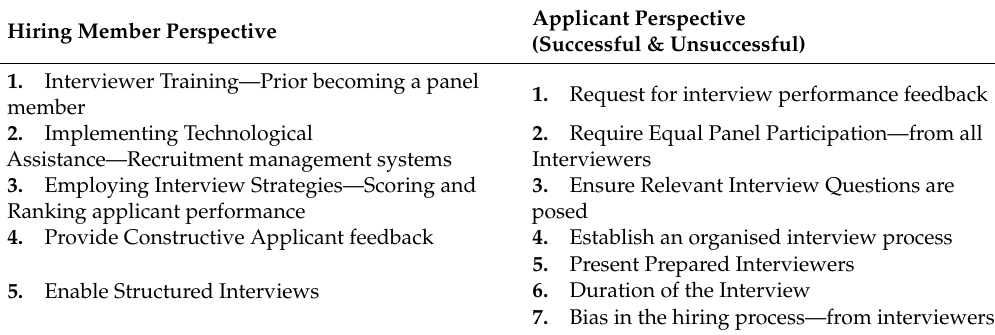
Table 2. Enlisting Aspects for Hypothesis